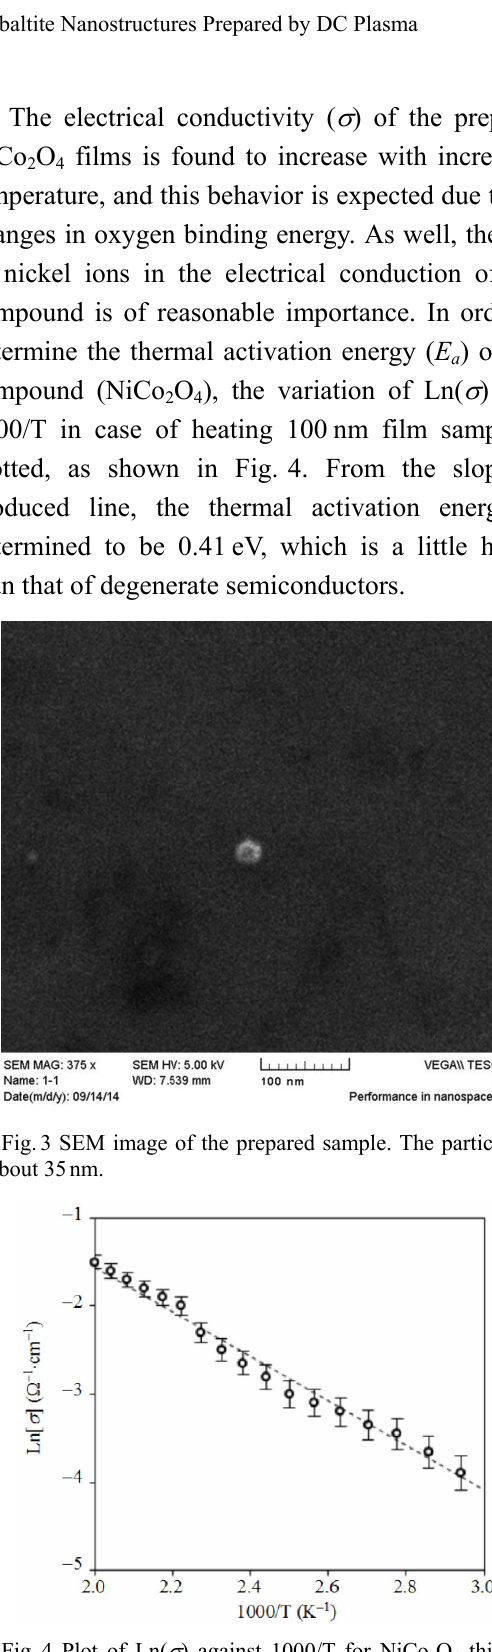
Fig. 4 Plot of Ln(  ) against 1000/T for NiCo 2 O 4 thin film during sample heating (thickness is 100 nm). The activation energy ( E a ) is determined from the slope to be about 0.41